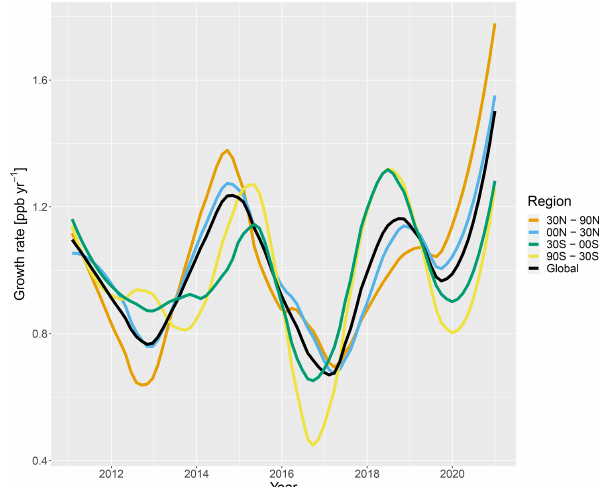
Figure 1. The observed atmospheric surface nitrous oxide growth rate derived from the AGAGE and NOAA networks for each month of 2011–2020 globally (black line) and in four latitude bands (coloured lines). The observations included are detailed in Sect. 2.1, and are combined into latitude band and global totals by weighting by the cosine of the latitude. The surface growth rate is calculated as the difference in the mole fraction between the month in the dis- played year and the year before, and has been smoothed using a LOESS (locally weighted smoothing) algorithm with a span of 0.3.